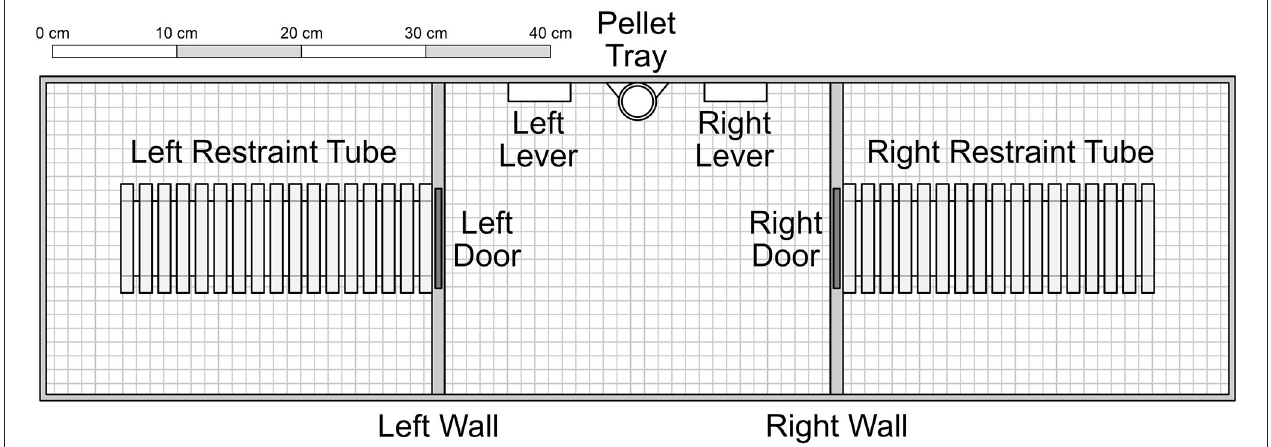
FIGURE 1 | Experimental apparatus, with components presented to scale. The inner left and right walls consisted of opaque plastic. The restraint tubes were cylinders composed of clear Plexiglas. Experimenters accessed each of the three chambers through clear Plexiglas ceiling hatches that acted as a roof when closed. Not shown are two indicator lights set into the wall immediately above each of the levers. Unless otherwise noted, components were composed of aluminum. In Conditions 1–4, pellets were delivered into the pellet tray from a dispenser outside the apparatus. In Conditions 5–7, food was dispensed into the right restraint